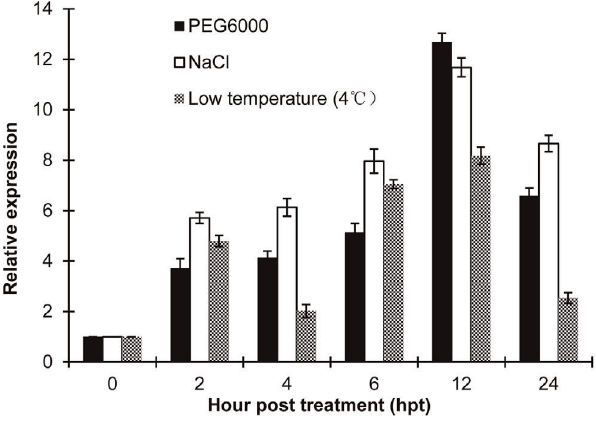
Figure 4. Assays for the transcript levels of TaRab7 during different treatment stages. Quantitative reverse-transcription poly- merase chain reaction analyses of TaRab7 expression in wheat exposed to environmental stresses. The data were normalized using the expression level of wheat translation elongation factor 1 alpha-subunit. Mean and standard deviation were calculated with data from three independent biological replicates. High salinity, 200 mM NaCl; drought, 20% PEG6000; low temperature, 4 u